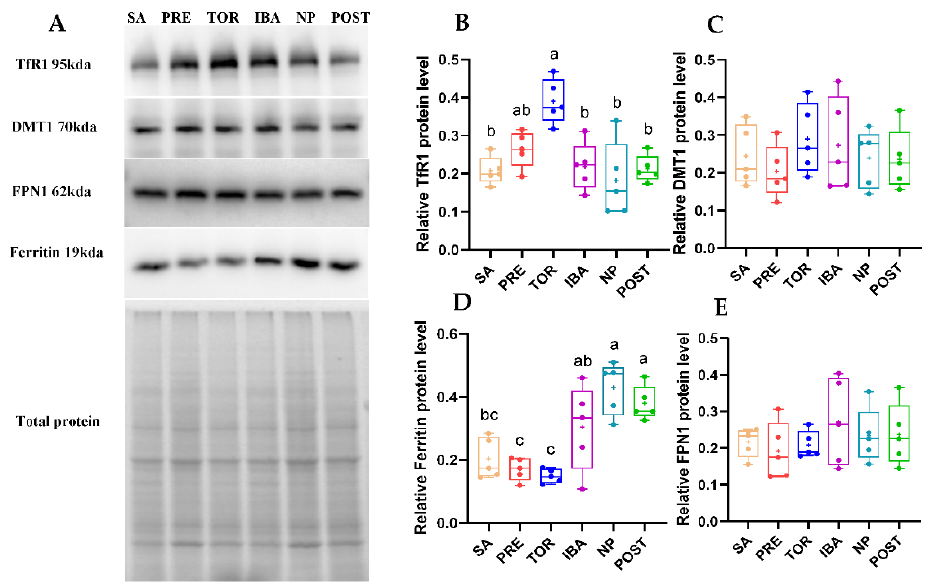
Figure 8. Changes in expression of iron-metabolism-related proteins in femur of Daurian ground squirrels during hibernation. ( A ) Western blot images of transferrin receptor 1 (TfR1), divalent metal transporter 1 (DMT1), ferritin, and ferroportin 1 (FPN1) in femur during hibernation (Figure S2, test 1). ( B – E ) Relative TfR1, DMT1, ferritin, and FPN1 protein expression in femur. SA, summer active group; PRE, pre-hibernation group; TOR, torpor group; IBA, interbout arousal group; NP, near post-hibernation group; and POST, post-hibernation group. Boxes represent upper and lower quartiles, middle horizontal line represents median, plus sign represents average, lines extending from upper and lower ends represent upper and lower edges, respectively, and points represent individual sample values ( n = 5). Superscripts with different letters indicate significant differences ( p < 0.05) among groups by Sidak test. Superscripts with same letters denote no significant differences ( p > 0.05).